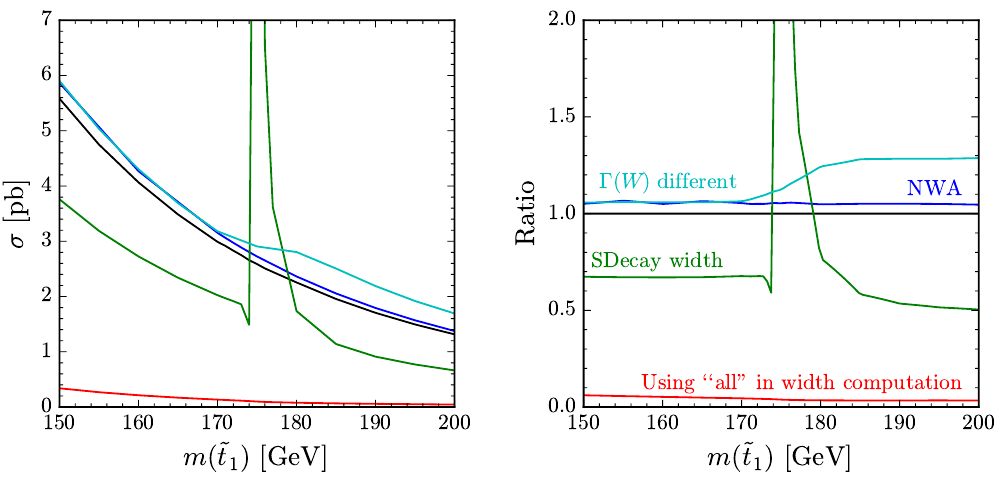
Figure 14 . The left panel shows the production cross section at p s = 8 TeV for the process (cid:22) b ‘ + ‘ ~ t ~ t 0 p p ~ (cid:31) 0 , while the right panel shows the ratio compared to the method (cid:0) (cid:23) ‘ (cid:22) (cid:23) ‘ ~ (cid:31) 1 1 ! b 1 1 ! used in this paper. The black lines show the value when the stop width is computed to the (cid:12)nal state particles. The blue lines are the narrow width approximation, wherein the total stop production cross section is multiplied by branching ratio for each W to decay leptonically. The green lines correspond to using the width obtained from SDecay , which includes NLO QCD corrections. The red and light blue lines come from common user